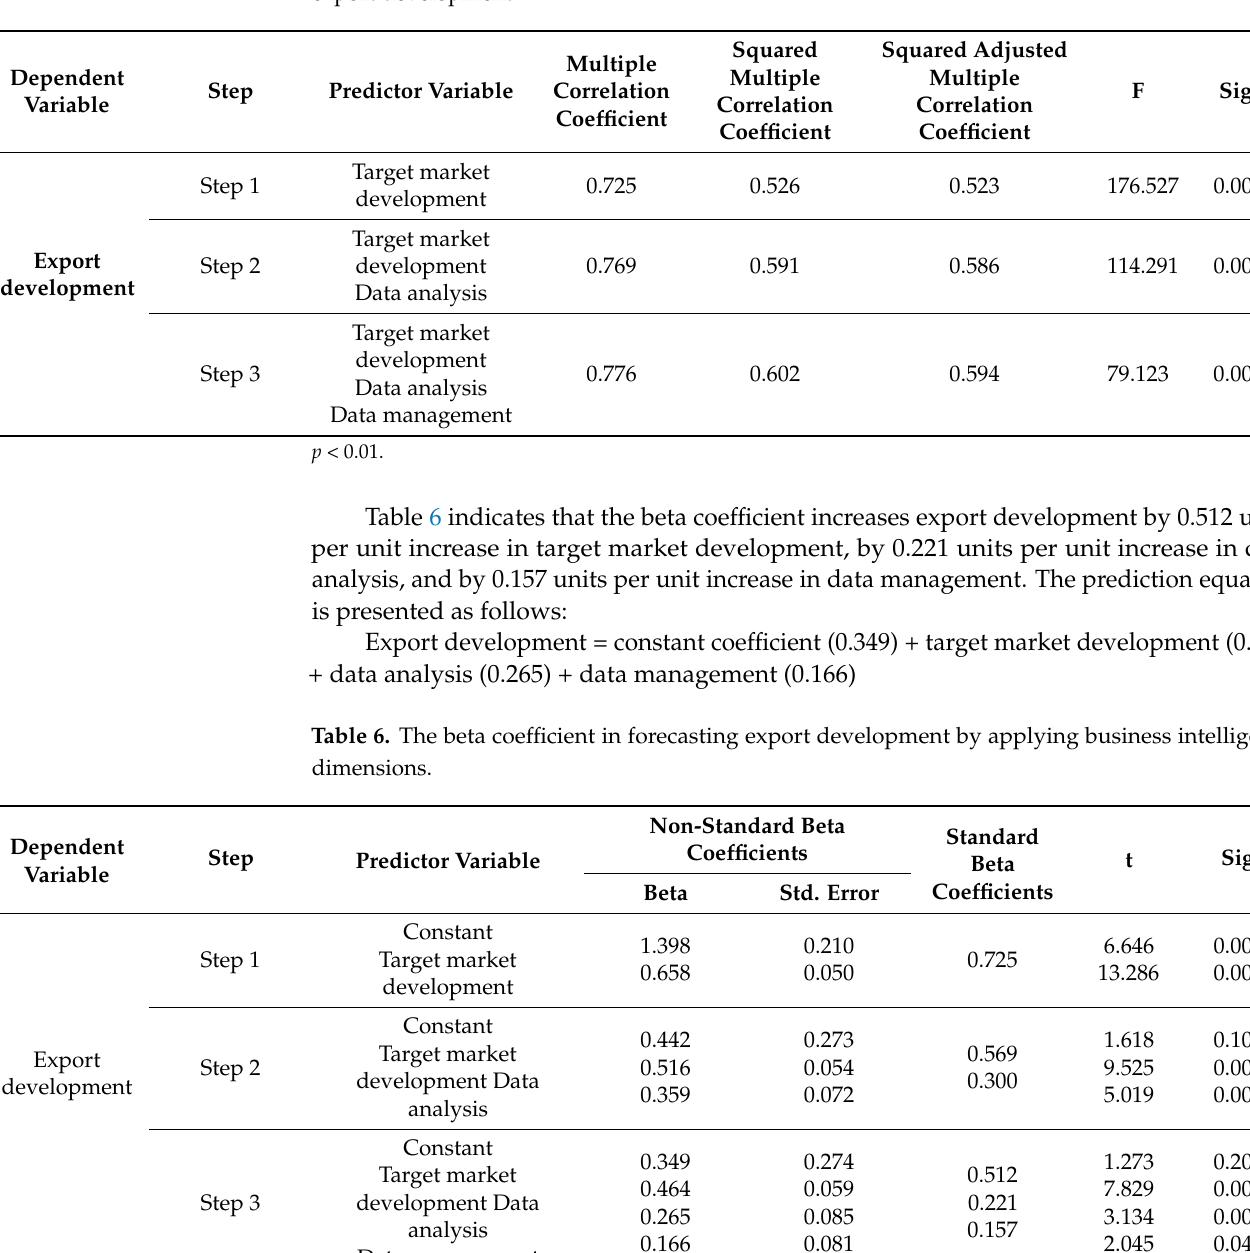
Table 5. Multiple coefficients of correlation between applying business intelligence dimensions and export development.